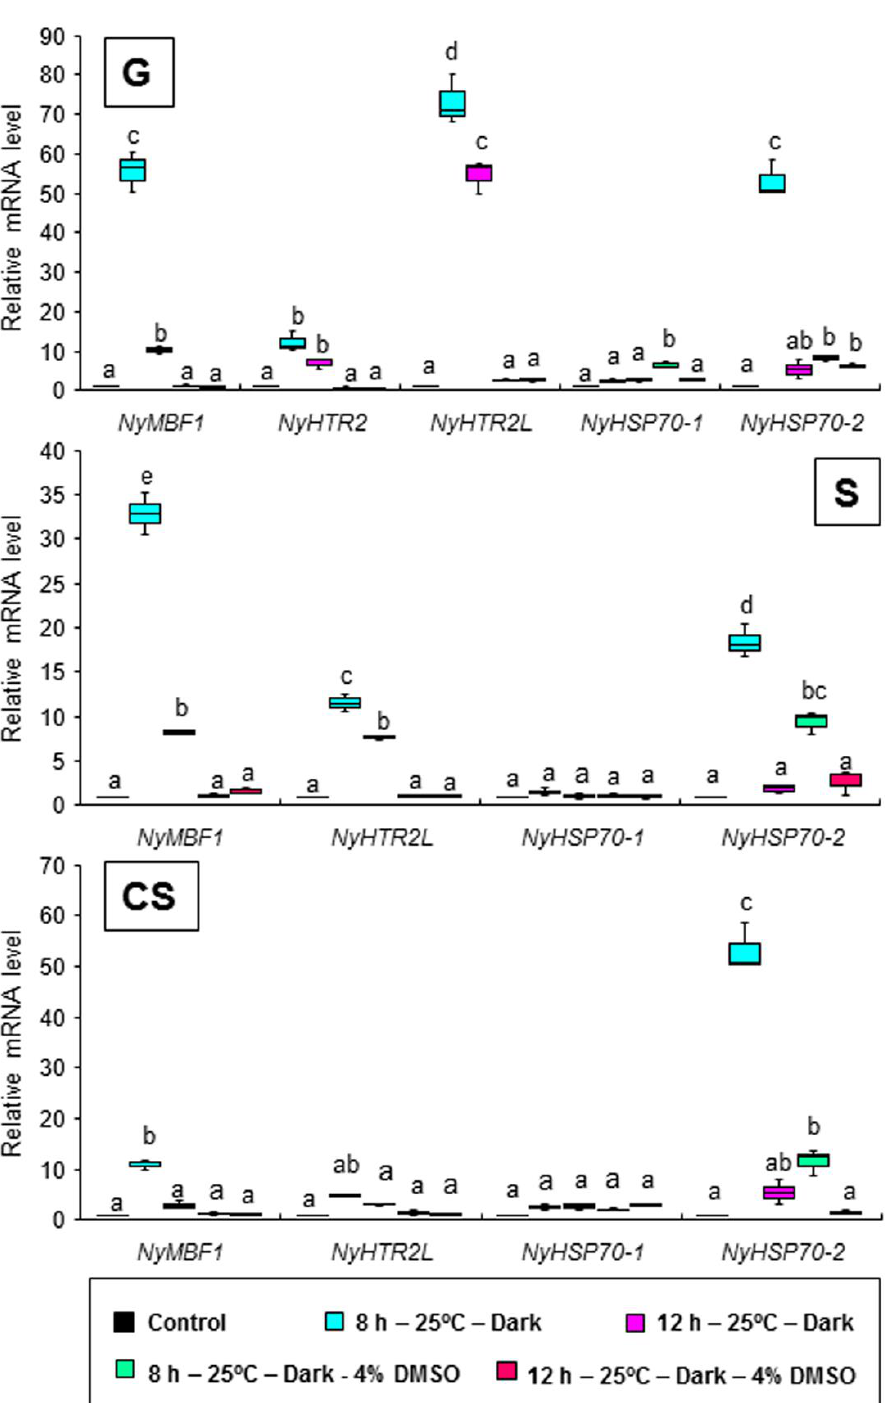
Figure 8. Reduction in the dark-induced second expression peak by membrane rigidification in three life cycle generations of Neopyropia yezoensis . The algae were treated with 4% DMSO, and expression of NyHTR2 , NyHTR2L , NyMBF1 , NyHSP70-1 , and NyHSP70-2 was examined 8 and 12 h after heat stress exposure (25 °C) in the dark. Relative mRNA levels were normalized using eIF4A as the reference gene. In the box plots, values on the Y axis represent the fold change of relative quantification of each gene. Different alphabetical letters denote significant differences in expression level among the three life cycle generations from triplicate independent replicates as defined by Tukey’s test ( p < 0.05) in two-way ANOVA. G—gametophyte; S—sporophyte;